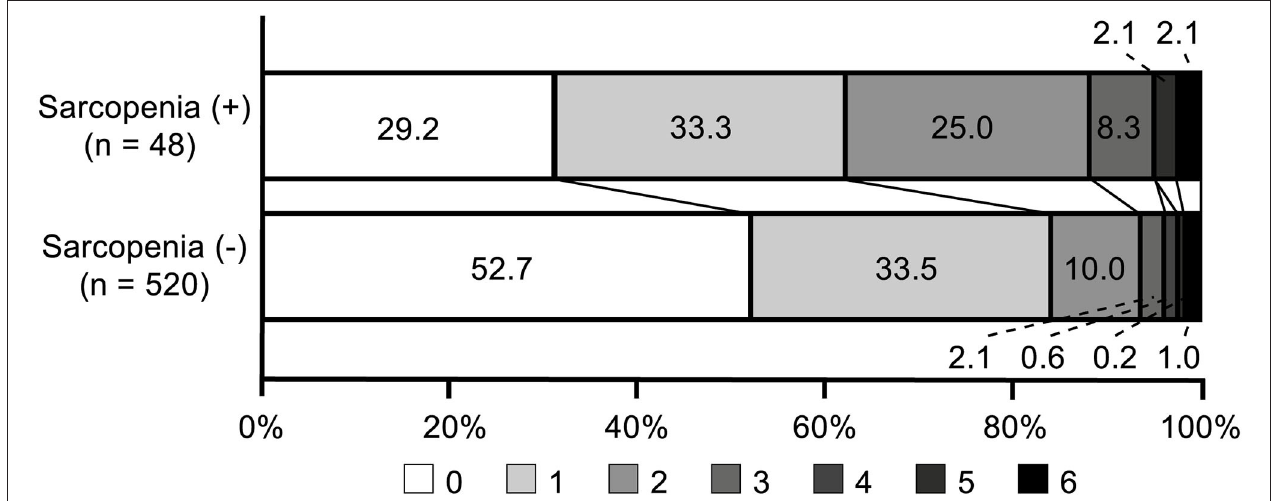
FIGURE 1 | Distribution of modified Rankin Scale scores at 90 days in patients with and without sarcopenia.